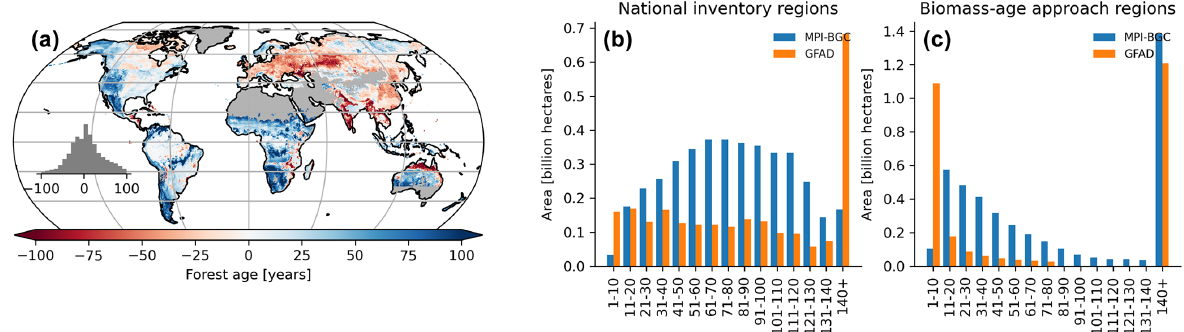
Figure 10. Difference map between the forest age estimates derived from the MPI-BGC and GFAD products (a) . Areas per age class were also compared between the two products for regions relying on national inventories (b) and relying on the biomass–age approach (c) in the GFAD product. Differences were computed using weighted age estimates from the fraction of the decadal age classes within each 0.5 ◦ grid-cell